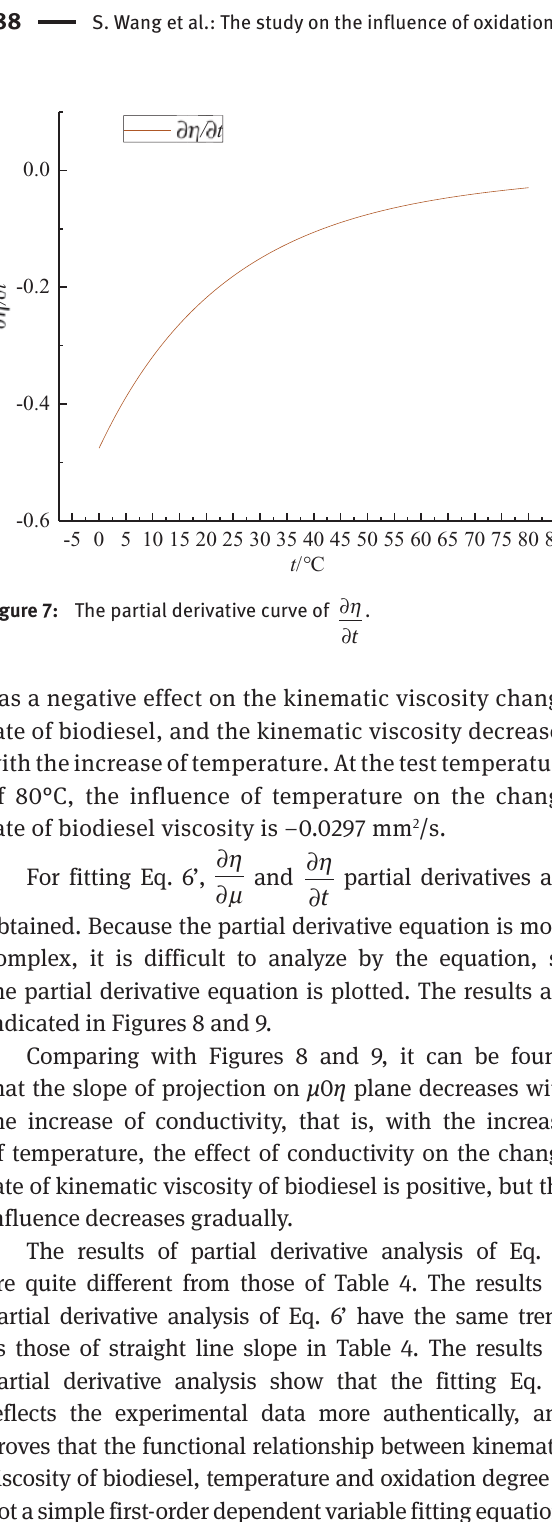
Figure 9: The partial derivative function diagram of